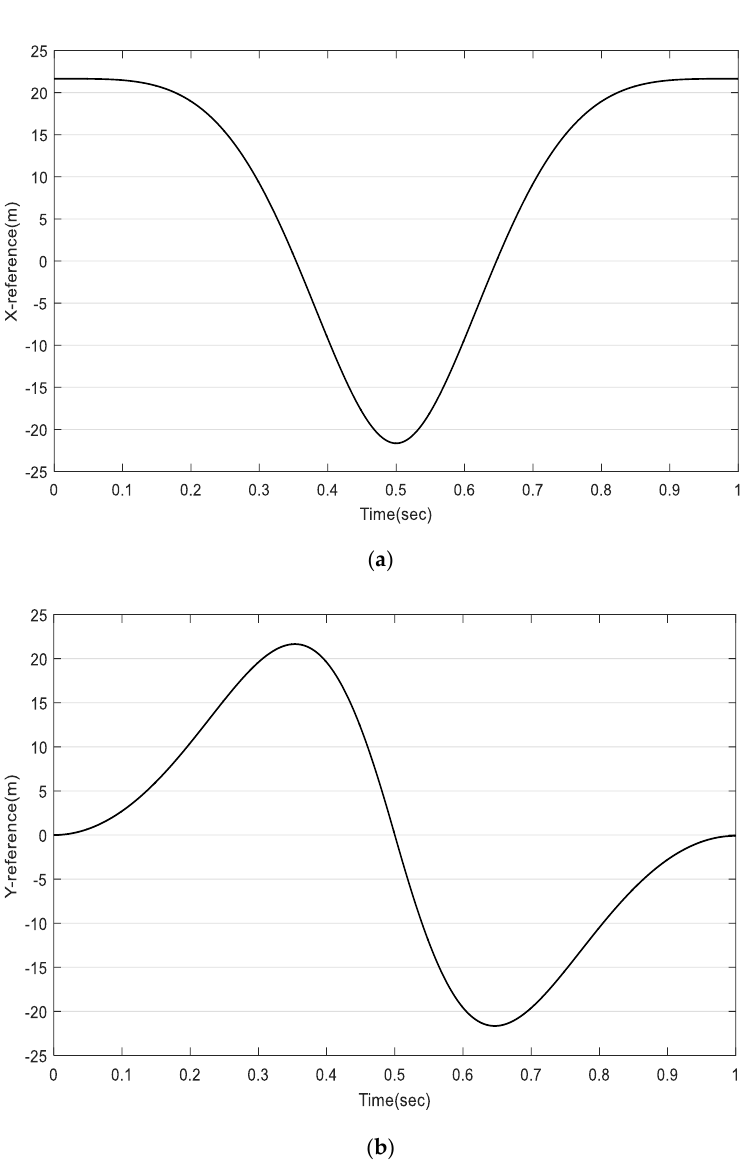
Figure 4. A plot of the reference trajectory: ( a ) X-coordinate; ( b ) Y-coordinate. Table 3. Main values of parameters for the proposed case study.